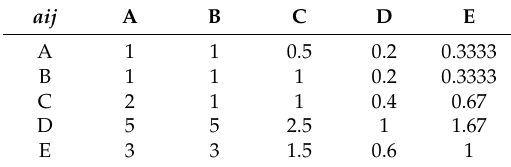
Table 6. Judgment matrix for area A.